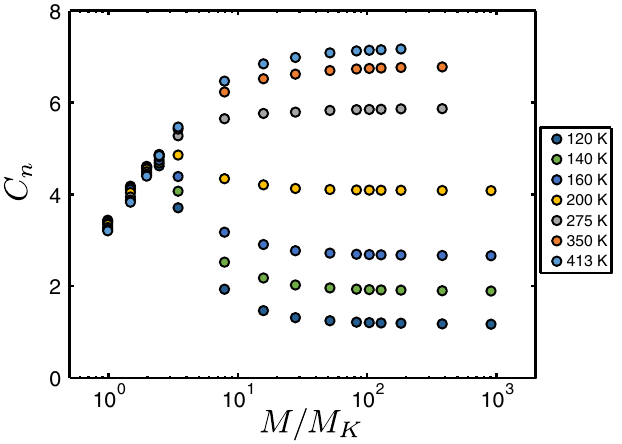
M; T Þ of PDMS calculated using the RIS model for FIG. 7. C n ð different T , as a function of molecular weight. The maximum at lower T is because the ground state of PDMS in the RIS model is a circle (degenerate helix) [53,60]. Note that the experimental 148 K, at which point the RIS calculations predict a high T ∞ g ¼ prevalence for loops. Experimental chain dimensions have been measured at T ¼ 298 K ( C ∞ ¼ 5 . 8 ) and T ¼ 413 K ( C ∞ ¼ 6 . 3 ) [105], and the RIS parameters were calibrated at T ¼ 343 K [94].